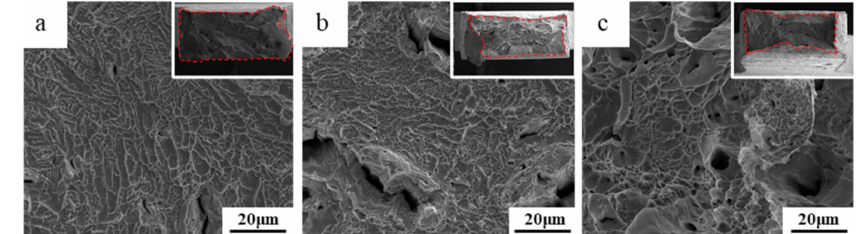
Figure 2. Fracture surfaces of EP0.58 at di ff erent temperatures: ( a ) 77 K, ( b ) 200 K, and ( c ) 293 K. The insets are the macrostructures of fracture surfaces.